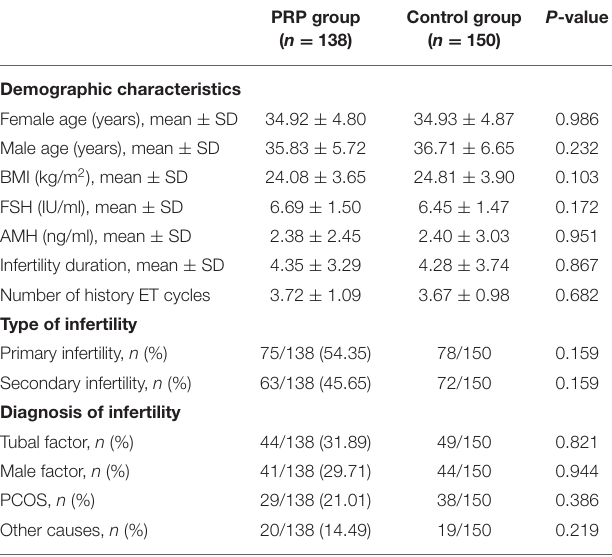
TABLE 1 | Baseline characteristics of the participants with RIF patients.